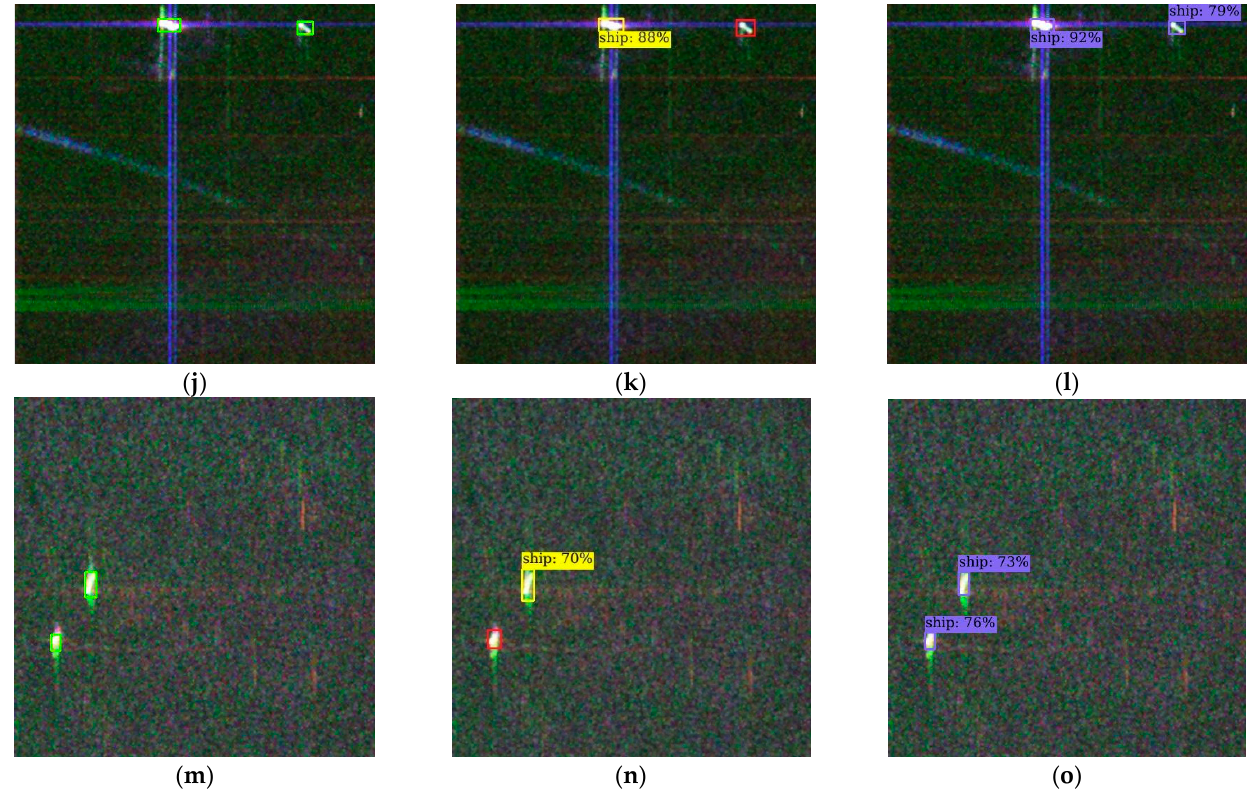
Figure 9. Ship detection results visualization: ( a , d , g , j , m ) the green rectangle represents the ground truth; ( c , f , i , l , o ) the blue rectangle represents the detection results of our proposed method; ( b ) the yellow rectangle represents the detection results of all classic detectors, the red rectangle represents the missed detection, and the meaning of the rectangle is the same in following detectors; ( e ) all classic detectors except SSD; ( h ) SSD; ( k ) YOLO v3 and YOLO v3-tiny and FCOS; ( n ) Cascade R-CNN and SSD and YOLO v3 and YOLO v4.